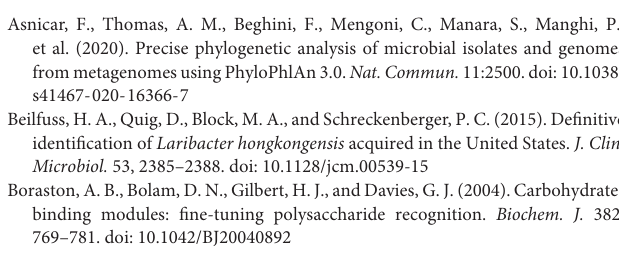
Supplementary Table 2 | The gene presence and absence matrix and annotation of all identified genes. Supplementary Table 3 | The functions of core genes were characterized by matching the sequences with the COG database. Supplementary Table 4 | Virulence factors detected in the 49 L. hongkongensis strains. Supplementary Table 5 | CAZyme profiling of the 49 L. hongkongensis